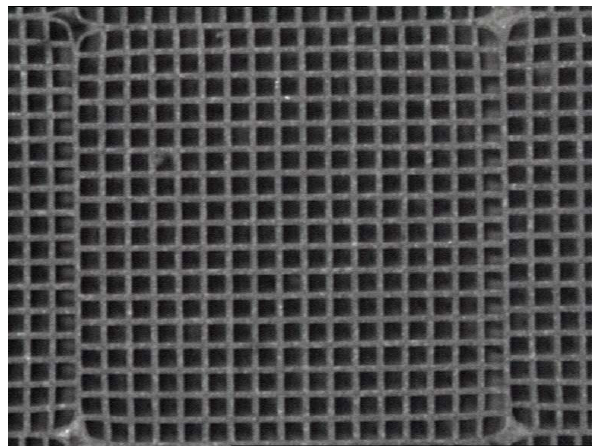
Fig. 11 . Top: Imager mounted on a three-axis stabilised (despun) platform, with FOV directed toward nadir. Bottom: Spin stabilised spacecraft, imager FOV is scanned over Earth.